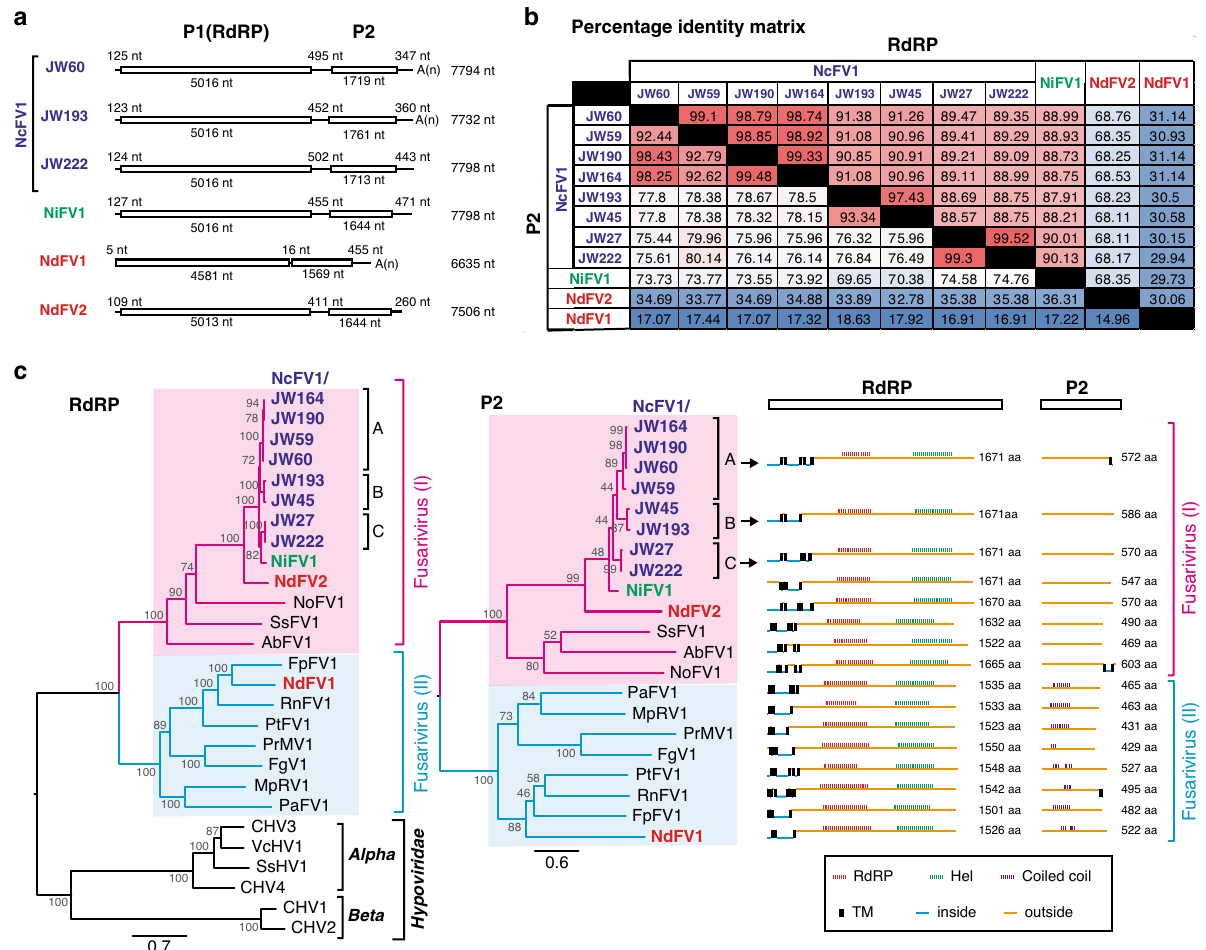
Fig. 2 Sequence and phylogenetic analyses of fusariviruses detected from the strains of Neurospora species. a Genome structure of Neurospora crassa fusarivirus 1 (NcFV1), Neurospora intermedia fusarivirus 1 (NiFV1), and Neurospora discreta fusarivirus 1 and 2 (NdFV1 and 2). The open boxes indicate open-reading frames (ORFs) with their lengths shown below. The lengths of the 5 ′ - and 3 ′ -untranslated regions, and intergenic regions, are indicated in nucleotides. b Percent identity matrix (PMI) among Neurospora fusariviruses generated by Clustal-Omega <https://www.ebi.ac.uk/Tools/msa/clustalo/>. The top half is the PMI of the viral RNA-dependent RNA polymerase (RdRP) and the bottom half is the PMI of ORF2 protein (P2, unknown function). c The maximum-likelihood (ML) phylogenetic trees were constructed based on alignment of the entire region of RdRP and P2 using RAxML-NG with 1000 bootstrap replications (left and middle panels). A LG + I + G4 + F model was selected as a best- fi t model for the alignment using ModelTest-NG. The trees are visualized by FigTree with the midpoint-rooting method. The two subclades of Neurospora fusariviruses (I and II) and three subgroups of N. crassa fusarivirus NcFV1 (A, B, and C) are indicated. The selected members of the family Hypoviridae are included as outgroups. The numbers on the left of branches indicate the percent bootstrap values. Putative secondary structures and functional domains of the RdRP and P2 proteins are shown on the right. Predictions of conserved domains and inside or outside of the membrane are predicted by SMART and TMHMM, respectively. Hel and TM indicate predicted helicase and transmembrane domains, respectively. Virus abbreviations are summarized in Supplementary Table